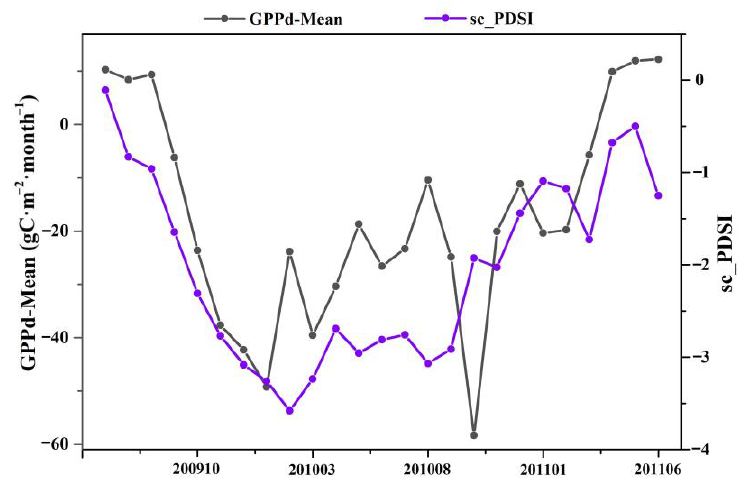
Figure 13. Changes in GPPd and sc_PDSI, 2009-06 – 2011-06.